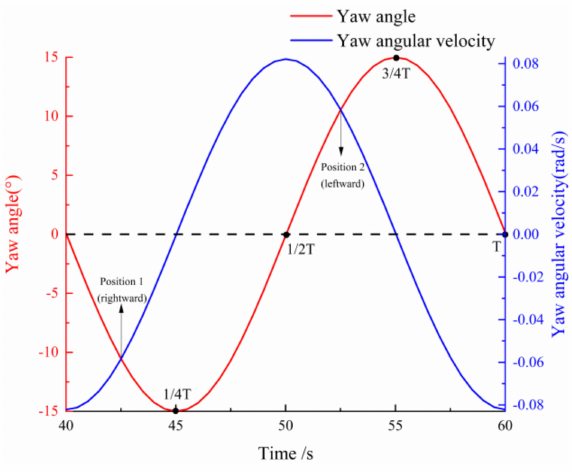
Figure 21. The two typical positions during yaw